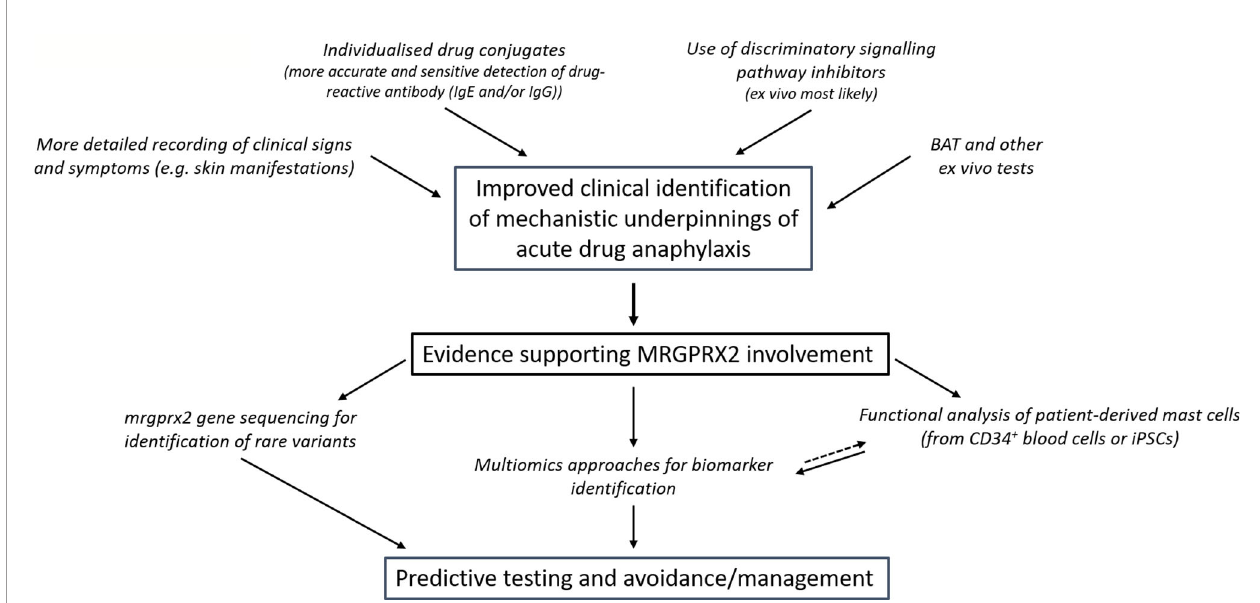
FIGURE 1 | Proposed approaches to overcome the current de fi ciencies in clinical discrimination of patients who suffer MRGPRX2-dependent anaphylaxis and their prospective value. Better de fi ning patients who likely suffered MRGPRX2 dependent anaphylaxis enables more focused, powerful and feasible research that can be used prospectively in predictive testing. The acute and commonly severe nature of drug-induced anaphylaxis means that discrimination between the pathways would likely have little consequence to the present-day management of patient symptoms. However, further comparative insights might highlight approaches that could perhaps provide more discrete bene fi t. (BAT- basophil activation